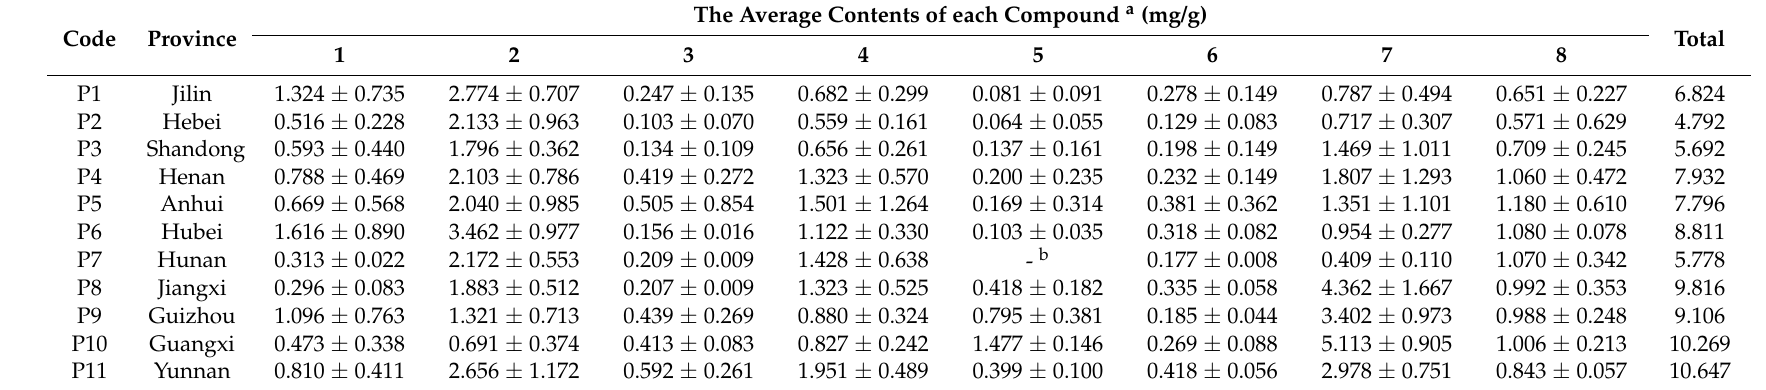
Table 5. Contents (mg/g) of eight investigated compounds in samples from 11